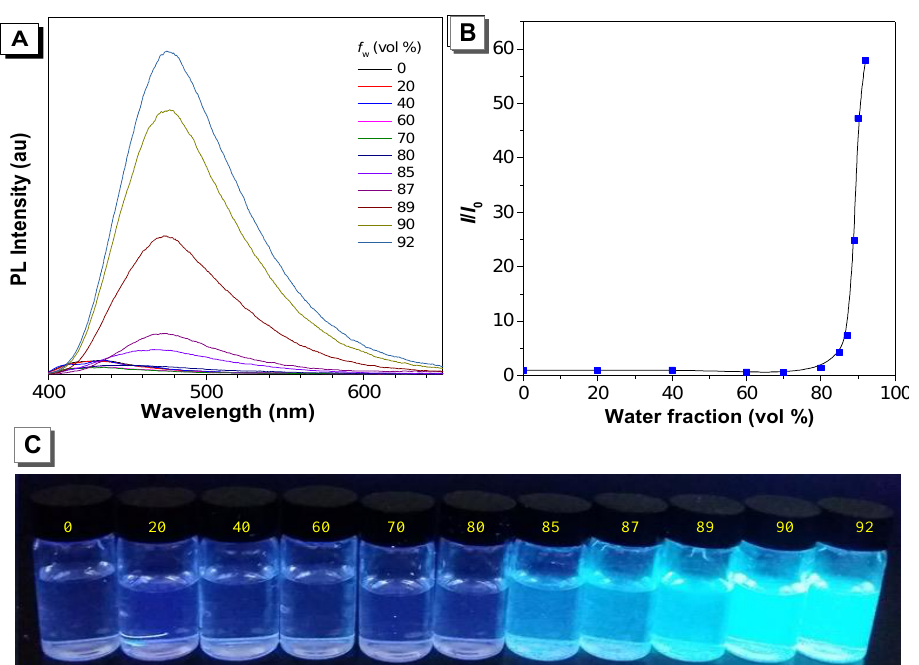
Figure 1. ( A ) Fluorescence spectra of compound 3 (5.0 × 10 − 5 M) in THF with different water fractions. λ ex = 340 nm, ex/em slit widths = 5/5 nm. ( B ) PL intensity ratio of I / I 0 in different THF/H 2 O mixtures. ( C ) Fluorescent images of compound 3 (5.0 × 10 − 5 M) with changing water fractions from 0 to 92% in THF under a 365 nm UV lamp.